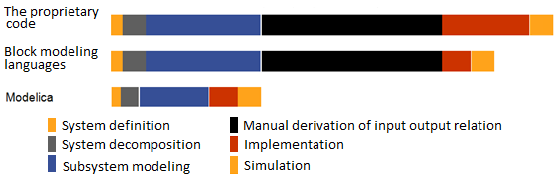
Figure 2. Development time chart.